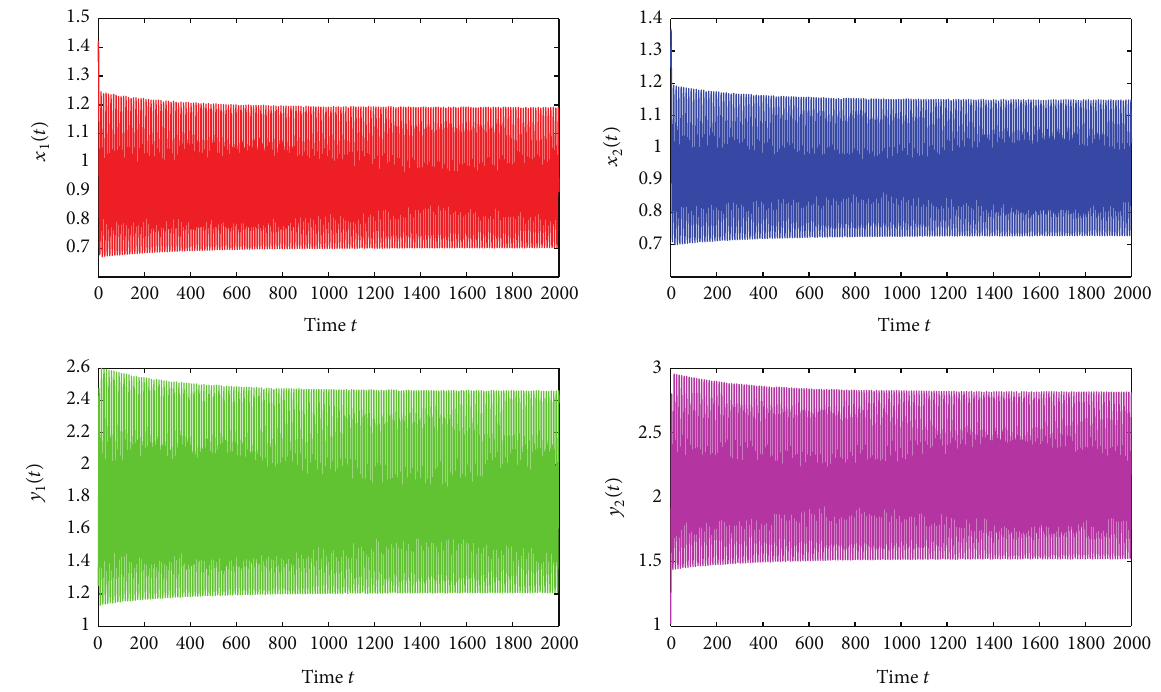
Figure 4: The track of the states 𝑥 1 , 𝑥 2 , 𝑦 1 , 𝑦 2 for 𝜏 1 = 4.71500 > 𝜏 10 = 4.5061 .